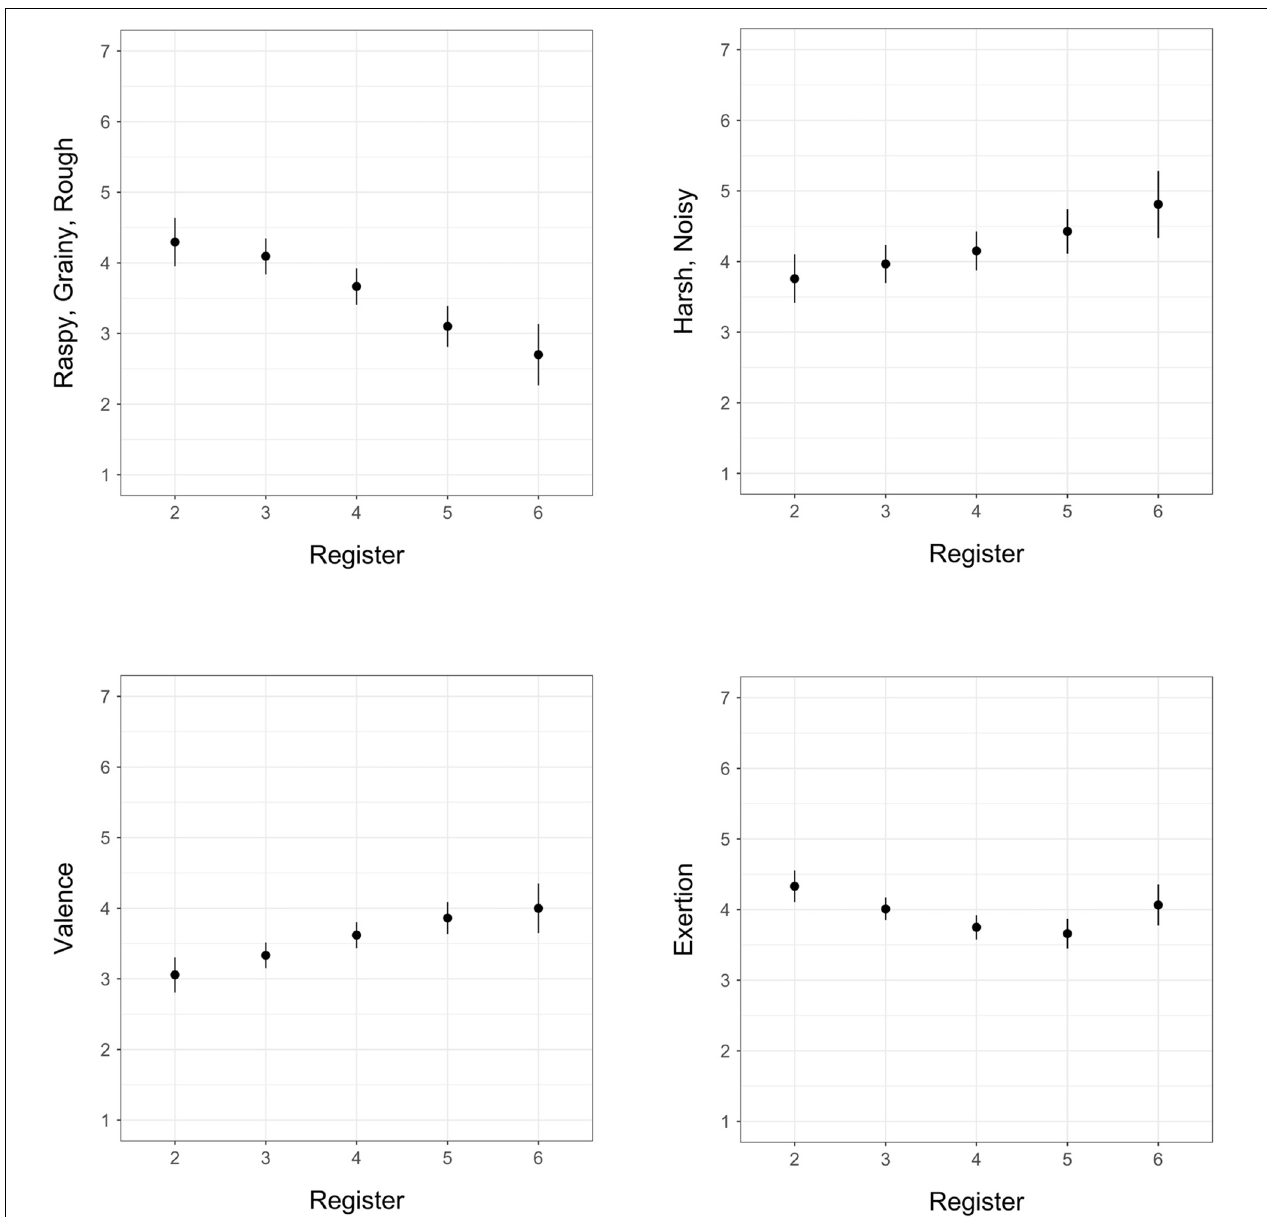
FIGURE 2 | Estimated marginal means for register (octave) in models of exertion, valence, raspy/grainy/rough , and harsh/noisy ; vertical bars represent 95% confidence